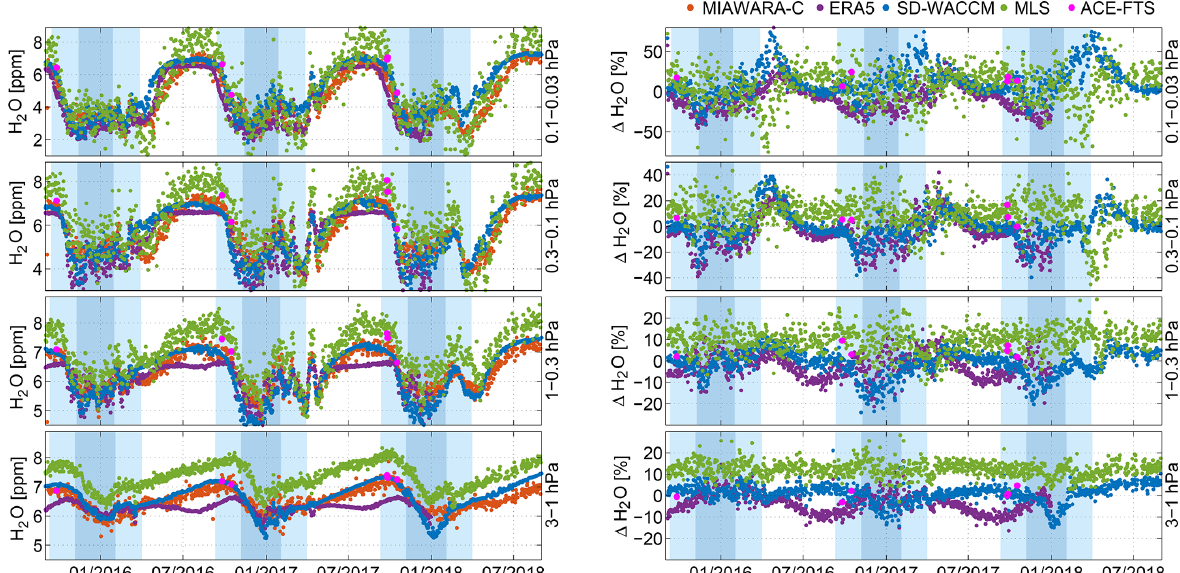
Figure 3. Intercomparison of water vapour time series at Ny-Ålesund. On the left are water vapour VMR time series of MIAWARA-C, MLS, ACE-FTS, SD-WACCM and ERA5 averaged within four pressure intervals where the upper three intervals are in the mesosphere and the lowest interval is in the upper stratosphere. On the right the relative differences to MIAWARA-C are shown for the same pressure intervals. The dark blue background indicates polar night and the white background polar day.